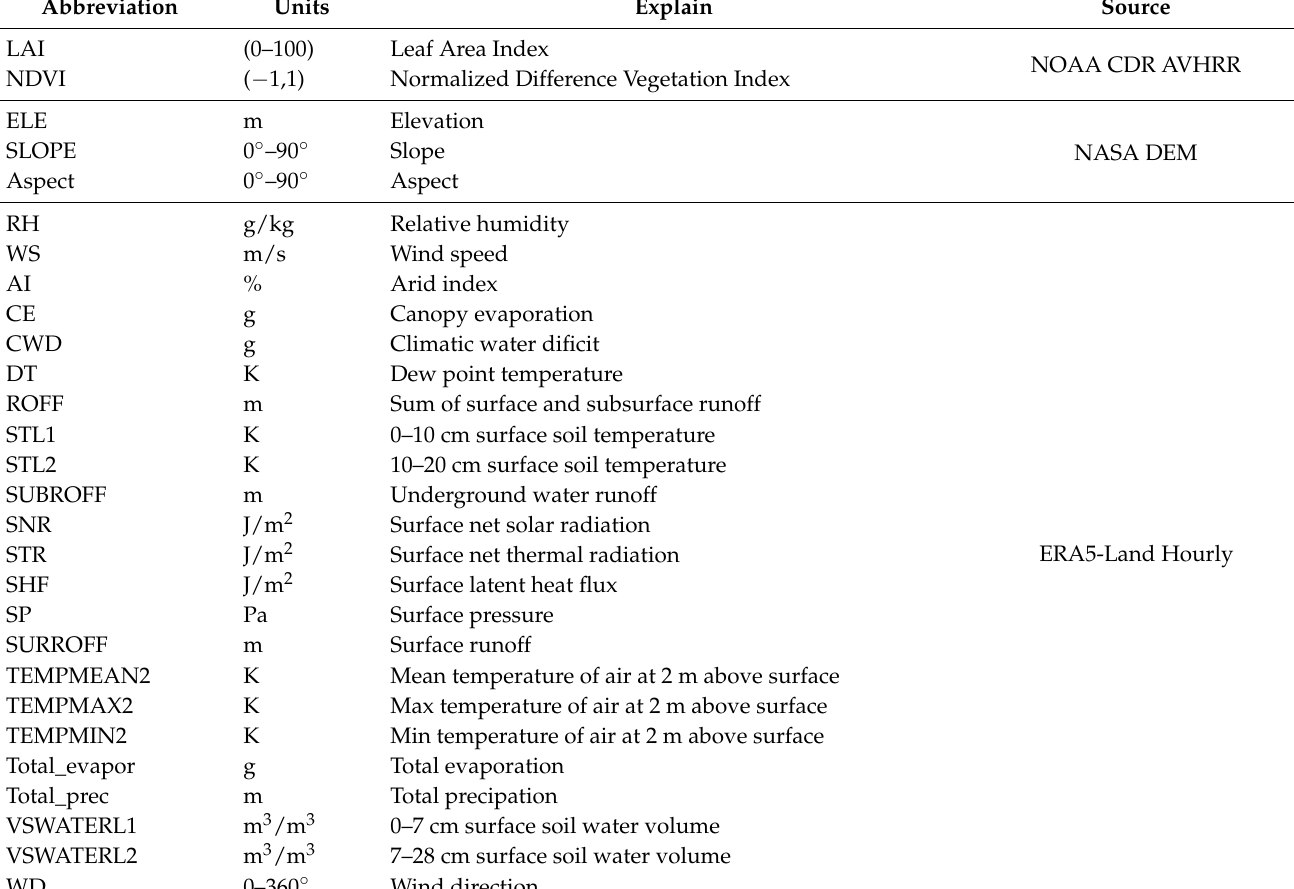
Table 1. Exploratory